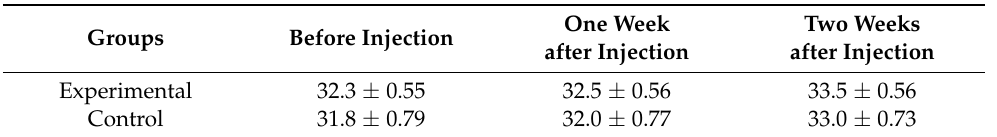
Table 1. Increase in body weight of white mice of the experimental and control groups that survived intoxication with the Ag 2 Se-AG